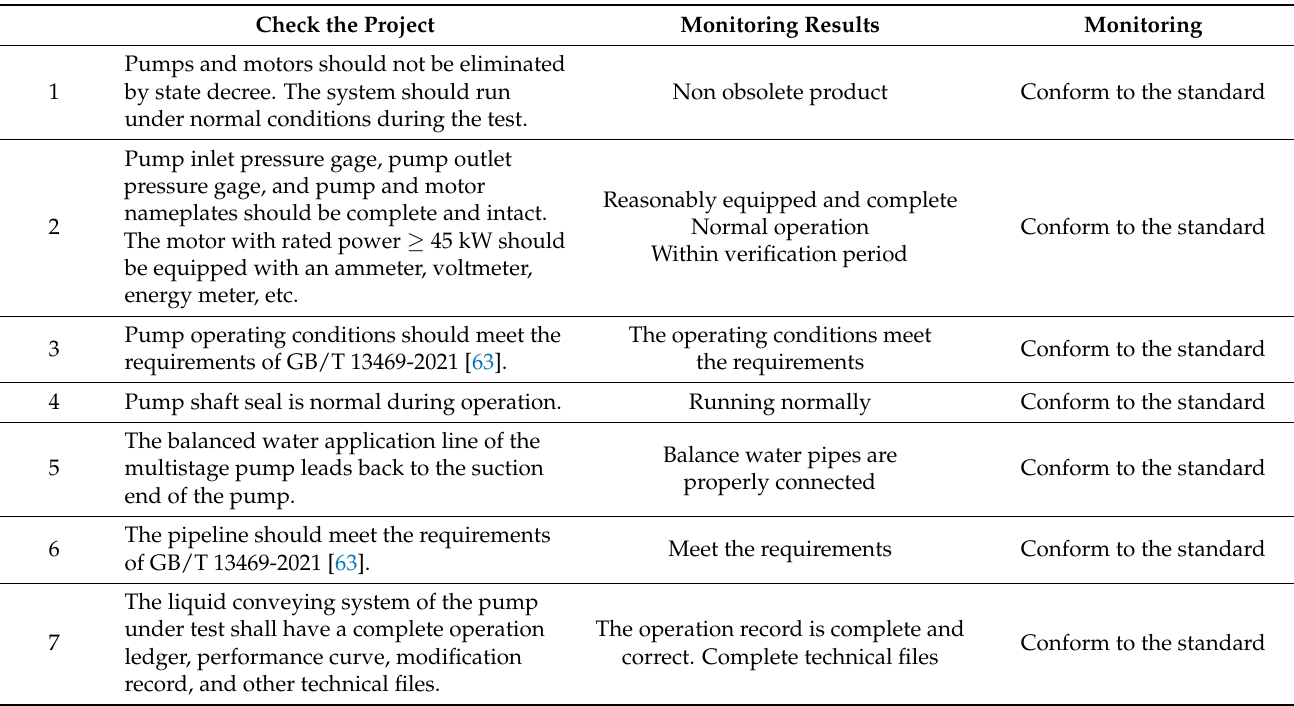
Table 3. Industrial testing: preliminary inspection items.